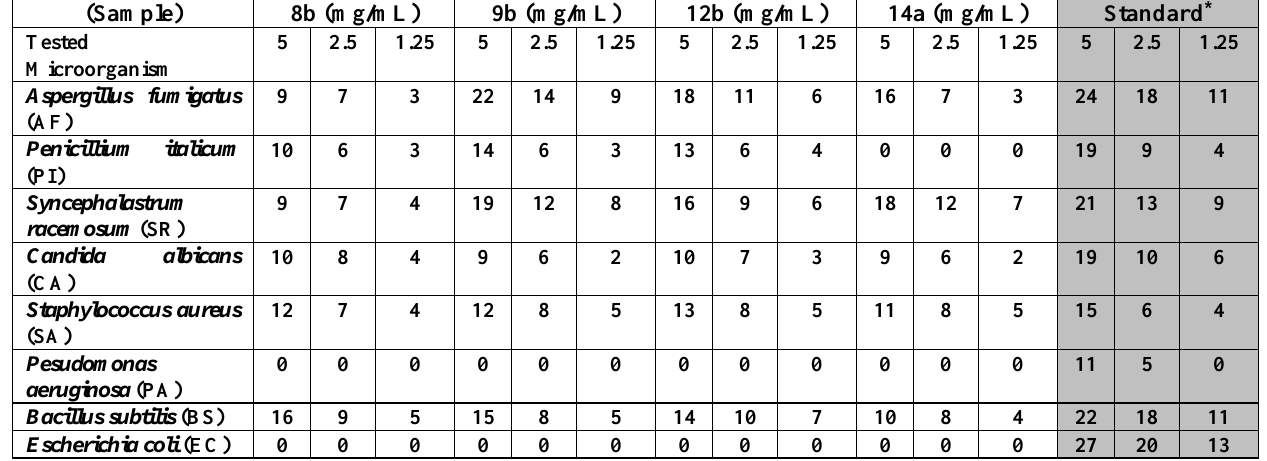
Table 2. Antimicrobial activity of products 8b , 9b , 12b , and 14a